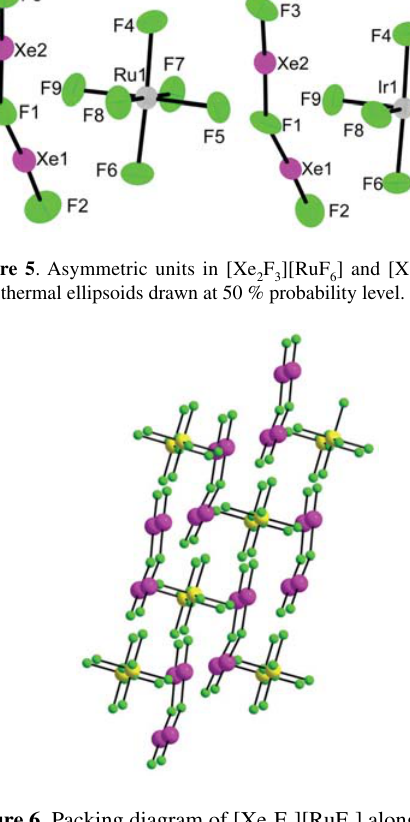
Figure 6 . Packing diagram of [ Xe